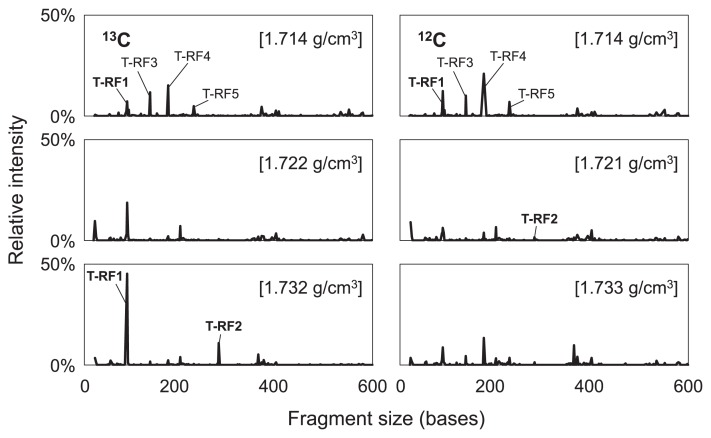
Terminal restriction fragment (T-RF) profiles of light, medium, and heavy fractions of the labeled (left column) and unlabeled (right column) treatments on day 64. Numbers in parentheses indicate the buoyant density of the fraction. Major peaks are numbered in the figures.